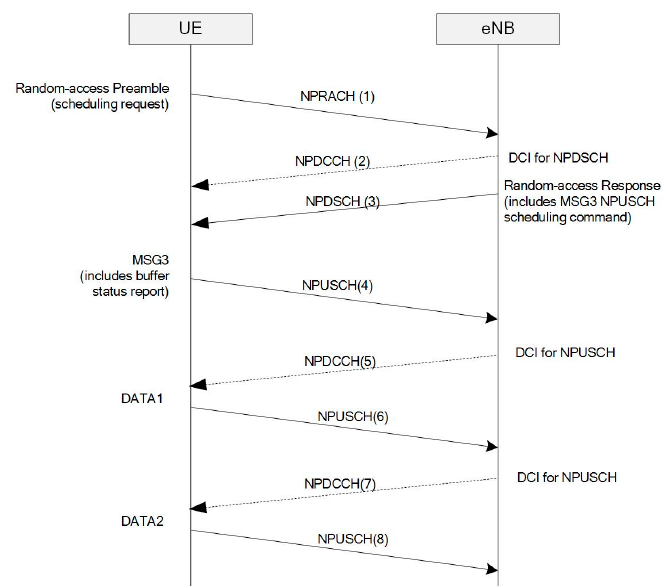
Figure 8. Scheduling request procedure with random access.